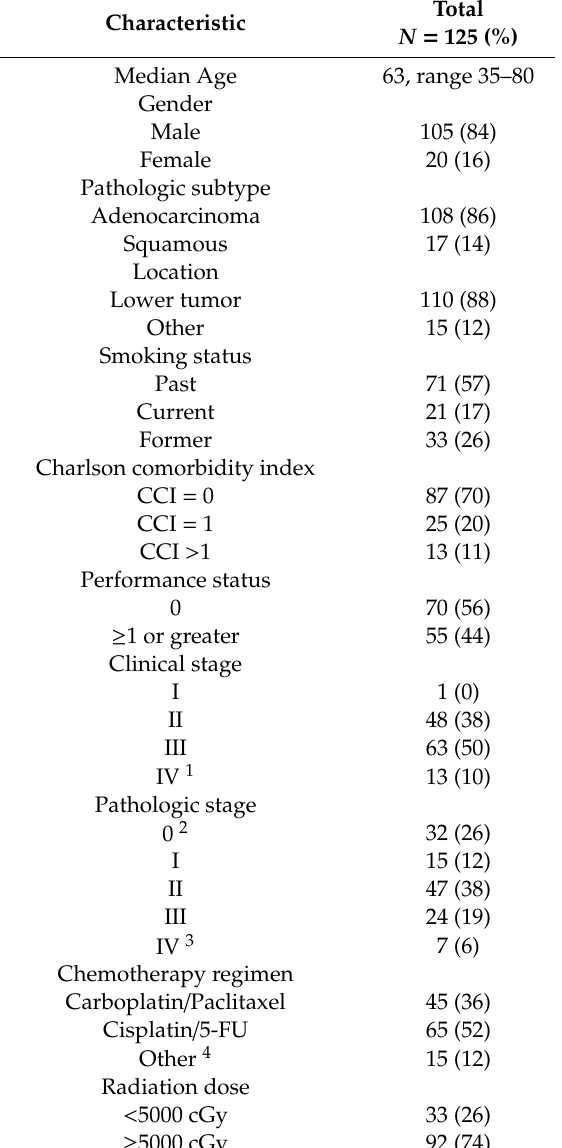
Table 2. Patient tumor and treatment